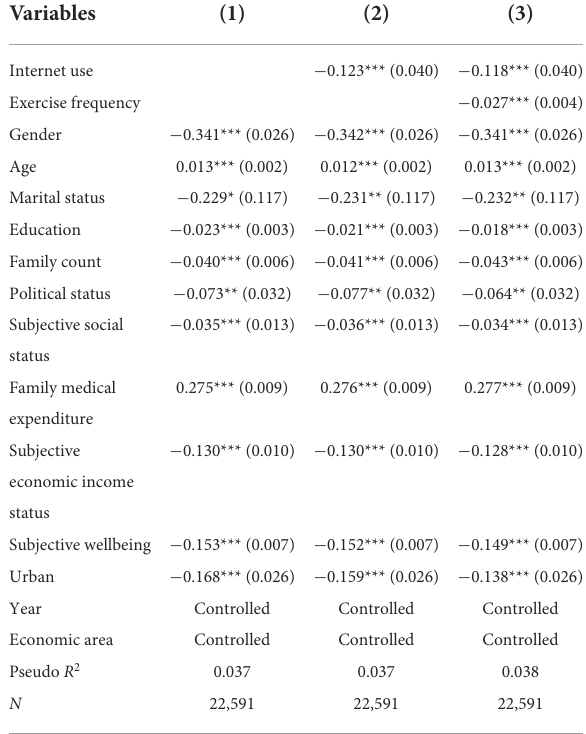
TABLE 2 Baseline regression results.